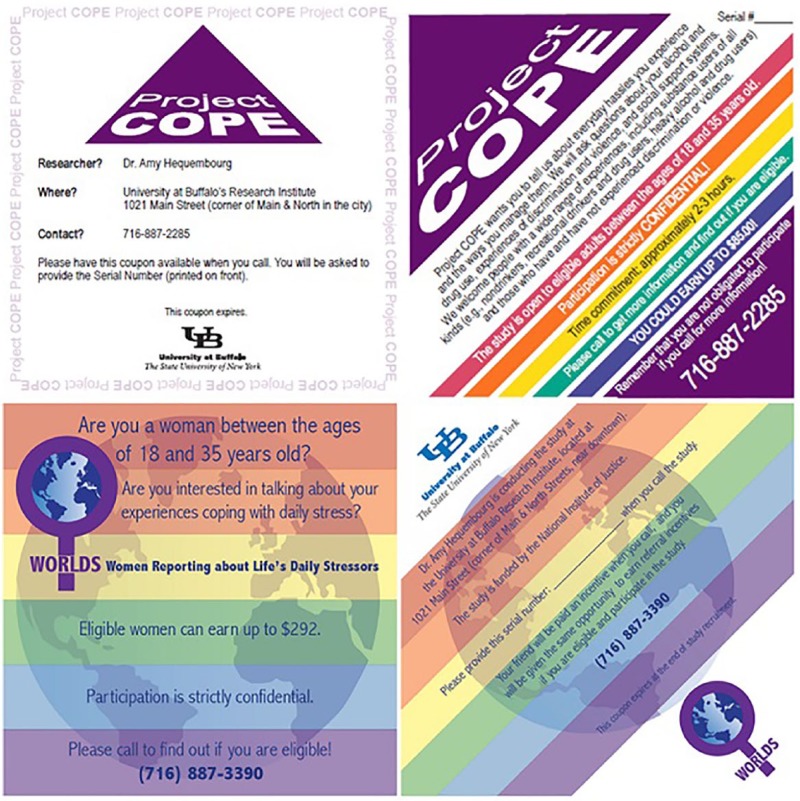
Referral coupons.